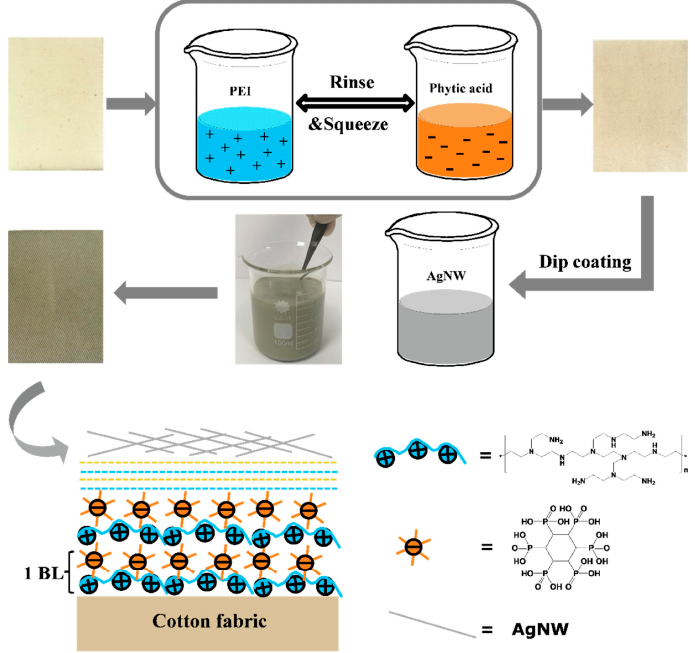
Figure 5. Illustration of layer-by-layer treatment and dip-coating method on cotton fabrics. From [71], copyright (2019), with permission from Elsevier.